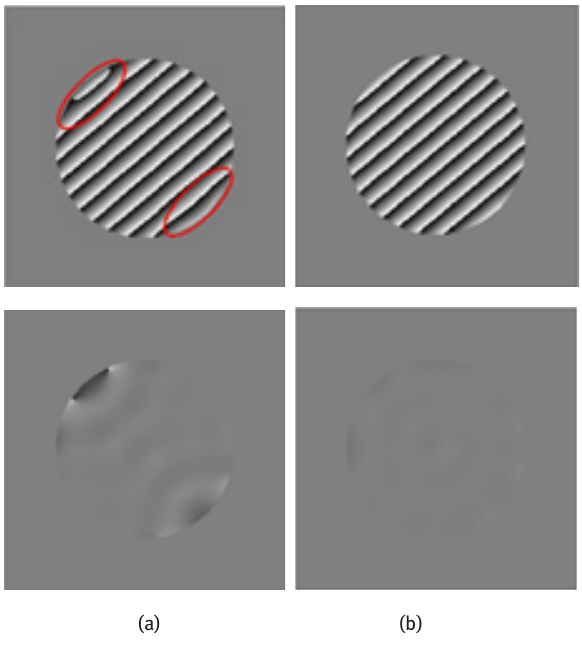
Figure 3: Top: Harmonic phase image, Bottom: Harmonic phase error (a) Obtained with original simulated image and (b) Obtained after DC component subtraction.